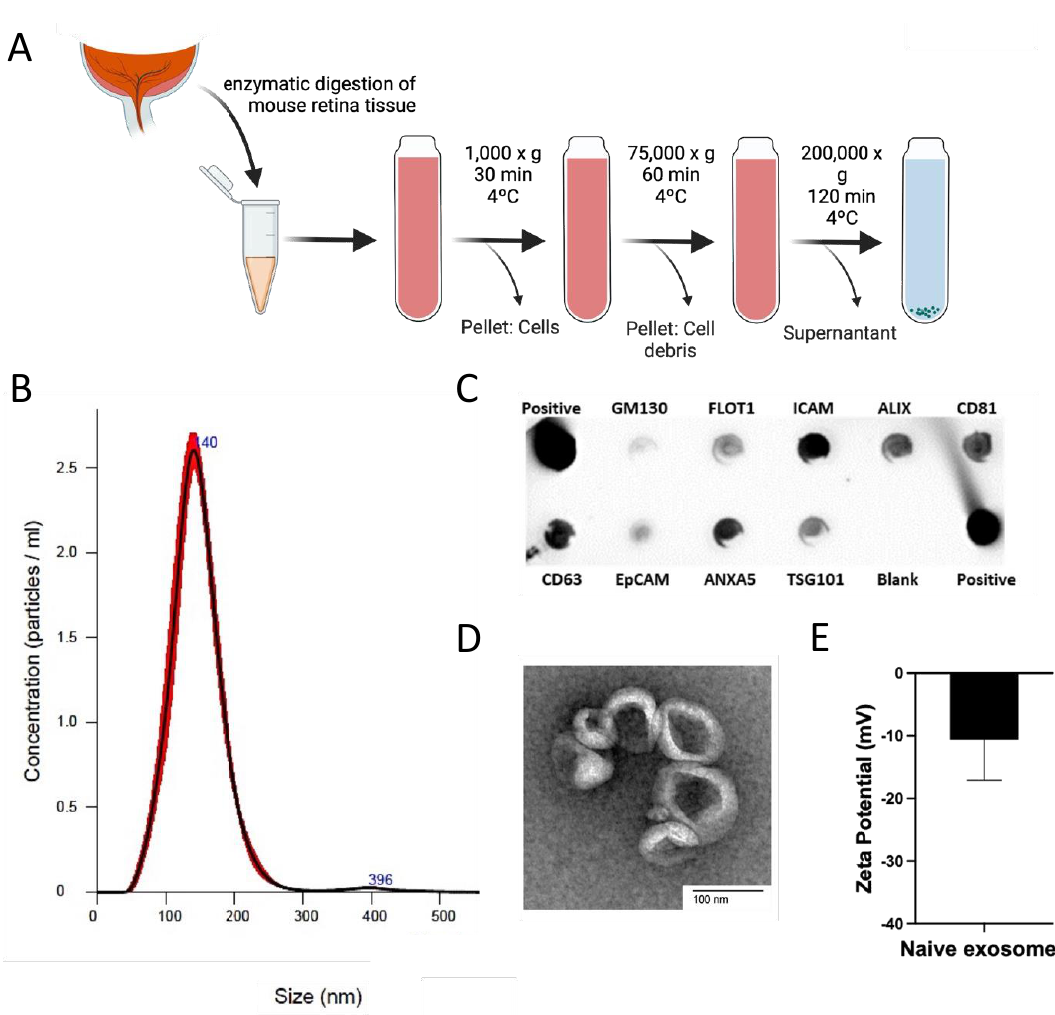
Figure 1. Recovery and characterization of retinal multicell-derived exosomes. Exosomes were recovered from the whole mouse retina by differential ultracentrifugation ( A ). The average peak size of exosome particles (140 nm) and an average number of particles of exosomes (2.1 × 10 9